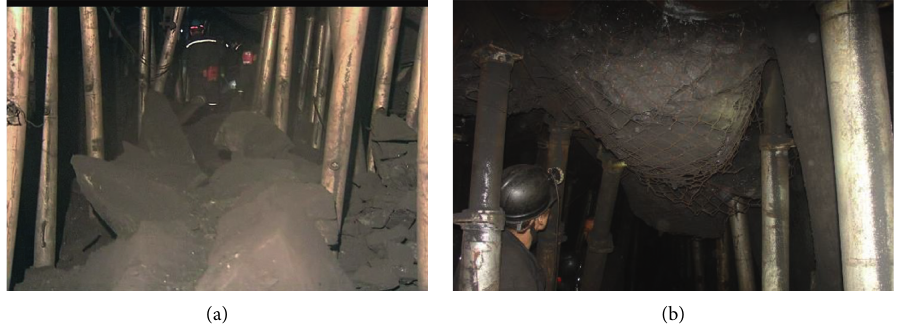
Figure 13: Roadway failure caused by release of strain energy. (a) Rock burst. (b) Roof